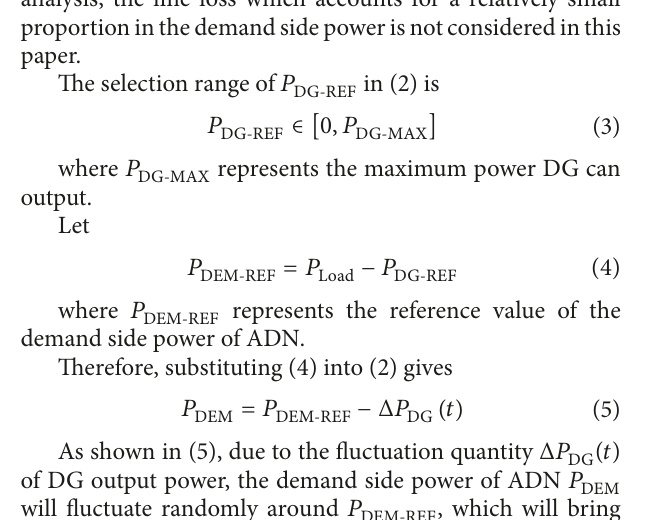
and Δ𝑃 DG (𝑡) represents the fluctuation quantity of DG output . In order to simplify power comparing with 𝑃 DG - REF